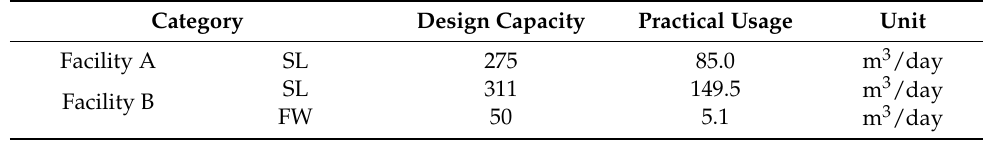
Table 1. Design capacity and operating